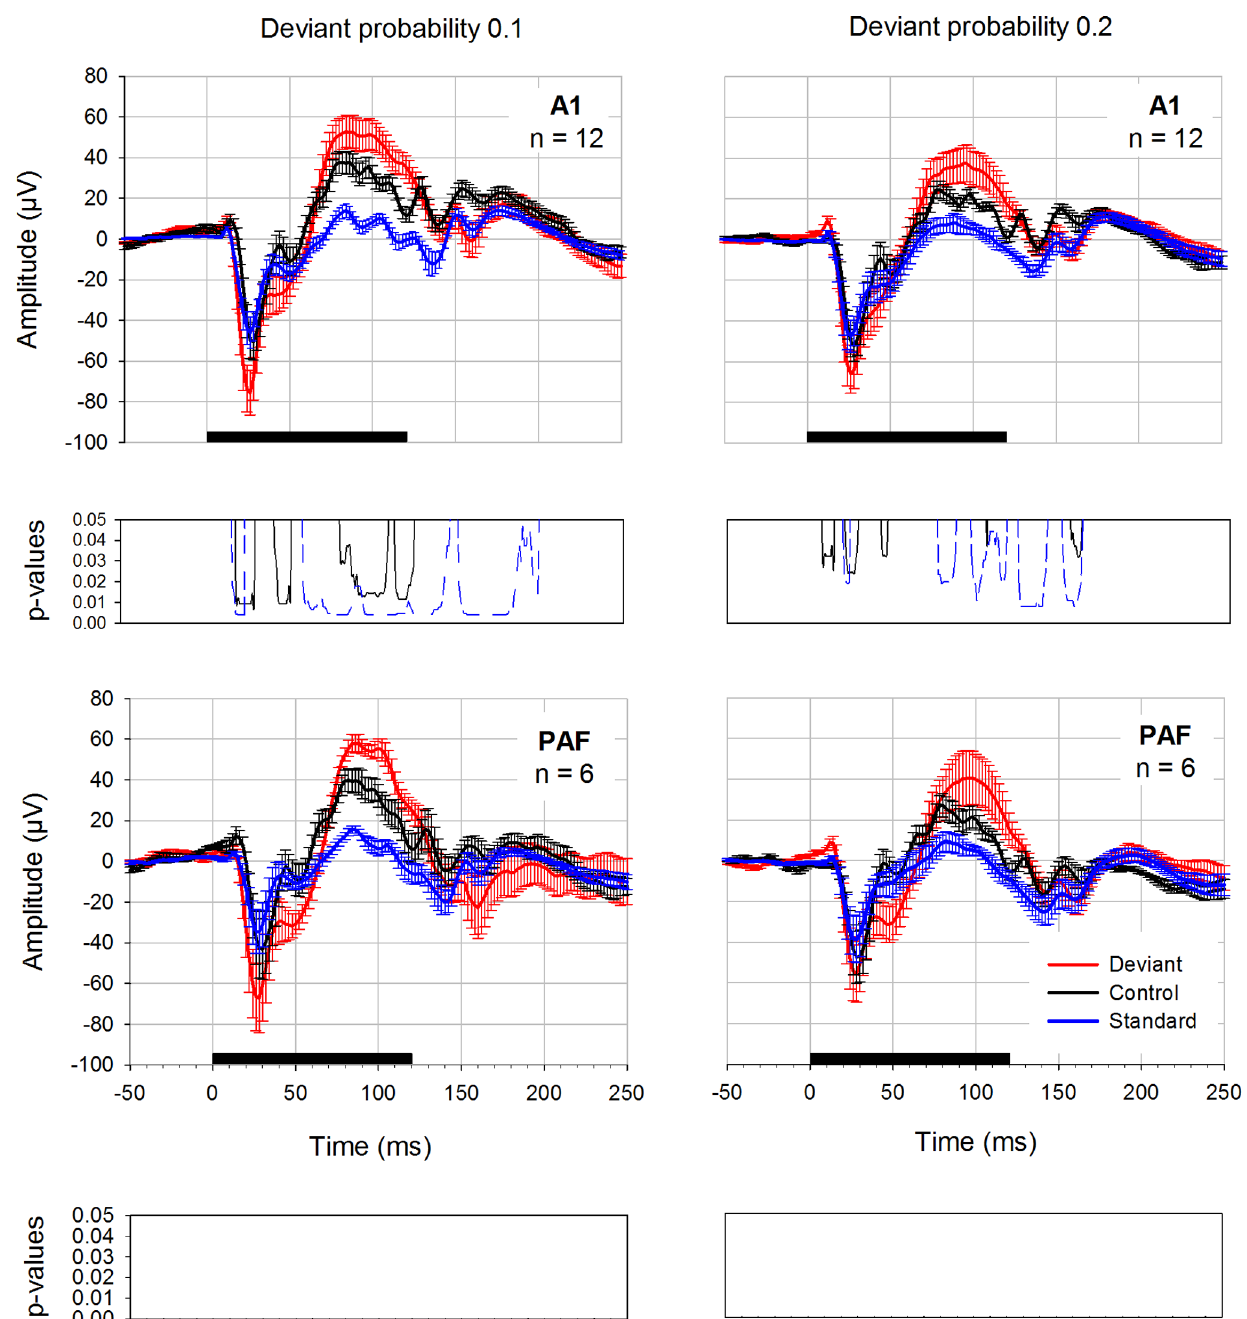
Figure 5. Oddball deviant compared to the equiprobable control condition. Oddball deviant (red curve), control ‘‘deviant’’ (black curve) and oddball standard (blue curve) potentials were elicited with either 0.1 deviant probability (diagrams on the left side) or 0.2 deviant probability (diagrams on the right side). Data is derived from 6 rats. The posterior electrodes on the left and right hemisphere as well as anterior electrodes on the left and right hemisphere were pooled for displaying the results and statistical calculation. Black bar on the x-axis shows stimulus duration. Below each graph FDR-corrected p-values are shown. The black curve displays the differences between oddball deviants and control deviants whereas the blue curve displays significant differences between oddball standard and control deviant. doi:10.1371/journal.pone.0063203.g005 counterbalanced across animals and blocks belonging to the same deviant probability were analyzed as one pair.